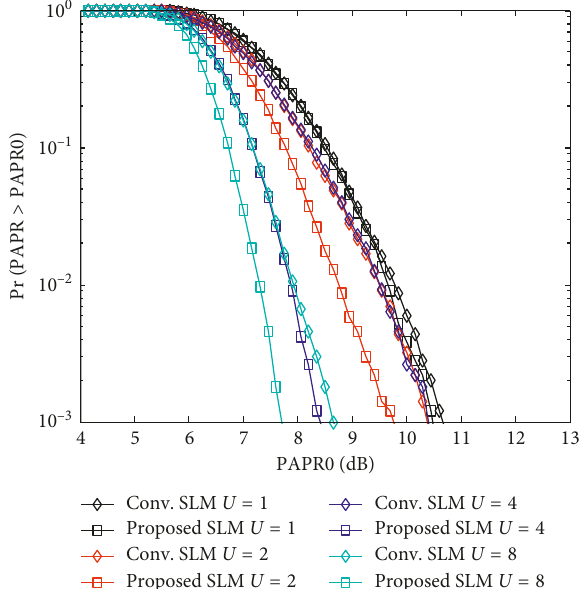
for U � 1, 2, 4, and 8, N � 128, and 8-PSK.